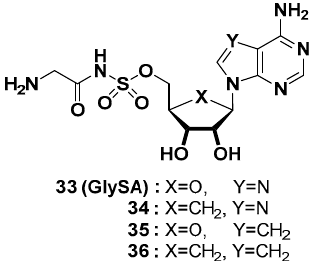
Figure 13. The structure of glycylsulfamoyladenosine derivatives (GlySAs) as eukaryotic glycyl- tRNA synthetase (GlyRS)